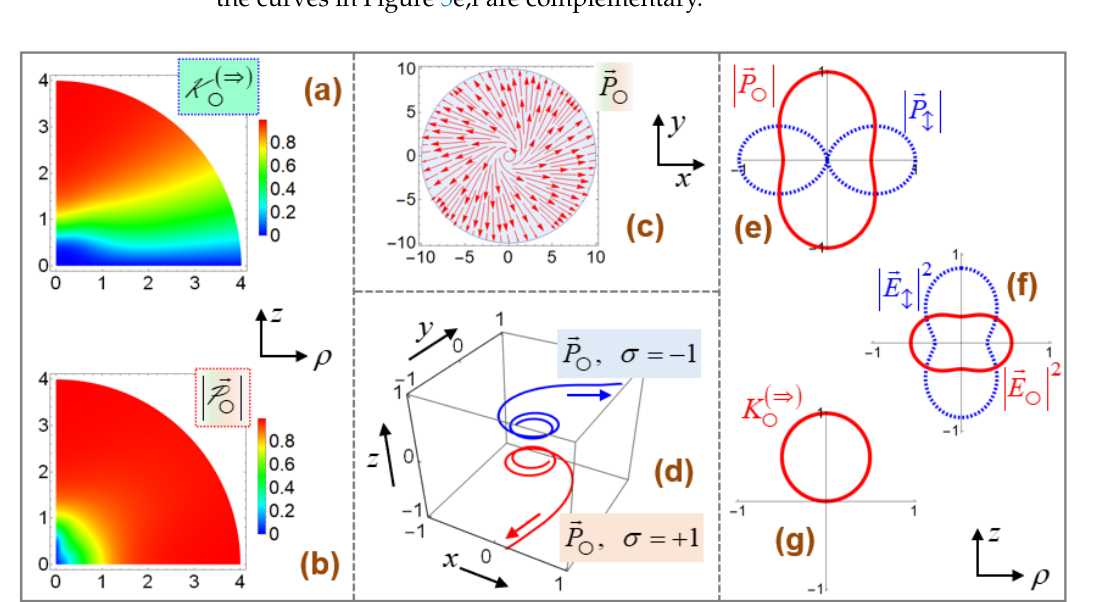
  into an orbital energy flux O and a spin